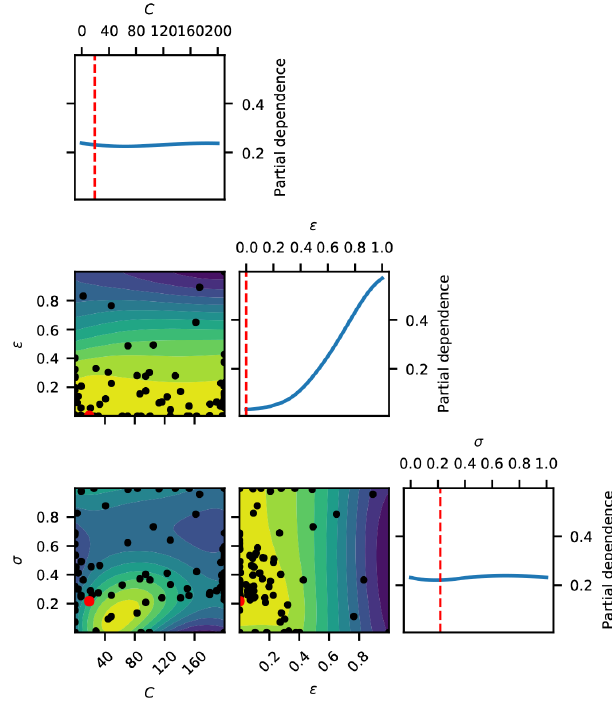
Figure 11. Pairwise partial dependence plot of the MSE objective function for the VMD-SVR scheme based on time-series data of the Huaxian